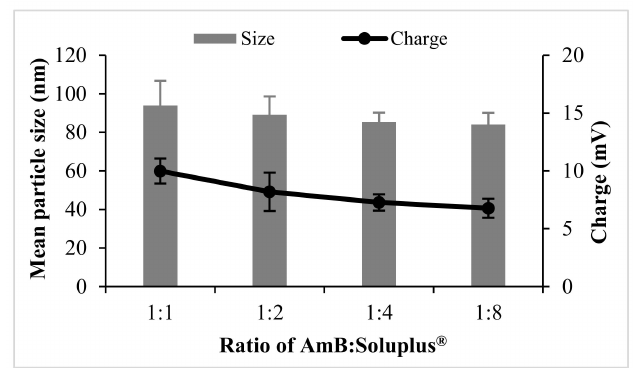
Figure 1. Particle size and charge of amphotericin B-loaded polymeric micelles (AmB-PM) prepared with di ff erent weight ratios of drug and polymers ( n = 3).